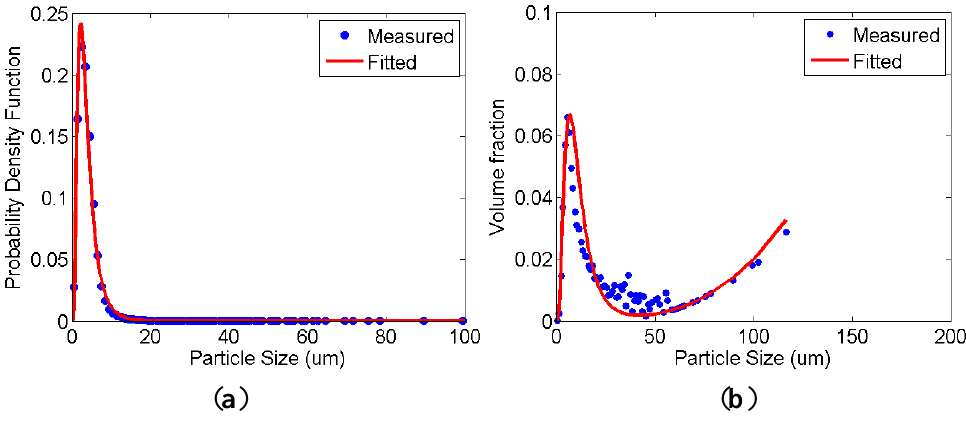
Figure 4. Size distribution of cement powder: ( a ) the measured number distribution and ( b ) the converted volume distribution.